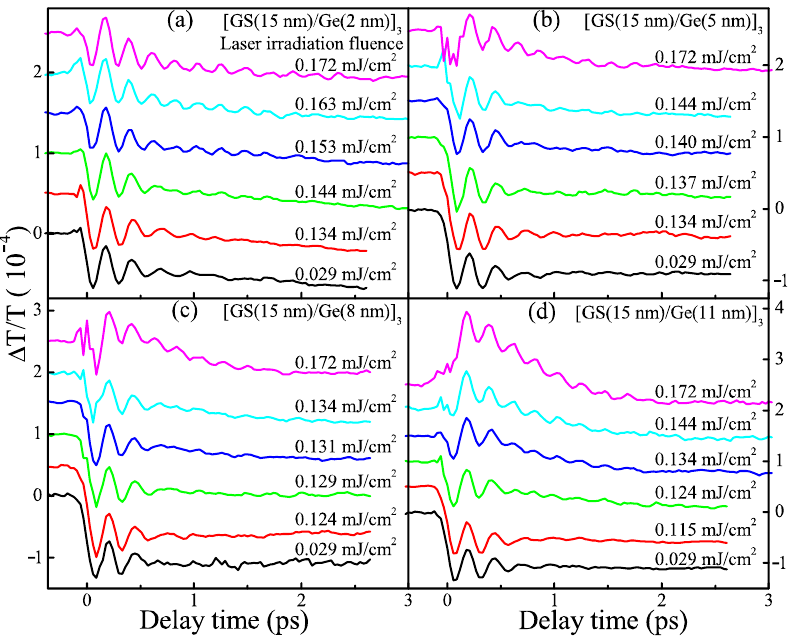
Figure 2. The dynamics of coherent phonon oscillation of four SLL samples measured by transient differential transmission after the irradiation of different laser fluence that is indicated over each dynamic profile. ( a ) [Ge 8 Sb 92 (15 nm)/Ge(2 nm)] 3 . ( b ) [Ge 8 Sb 92 (15 nm)/Ge(5 nm)] 3 . ( c ) [Ge 8 Sb 92 (15 nm)/Ge(8 nm)] 3 . ( d ) [Ge 8 Sb 92 (15 nm)/Ge(11 nm)] 3 . All measurements are taken under a same low pump fluence of 0.029 mJ/cm 2 . The curves are shifted vertically for clarity.